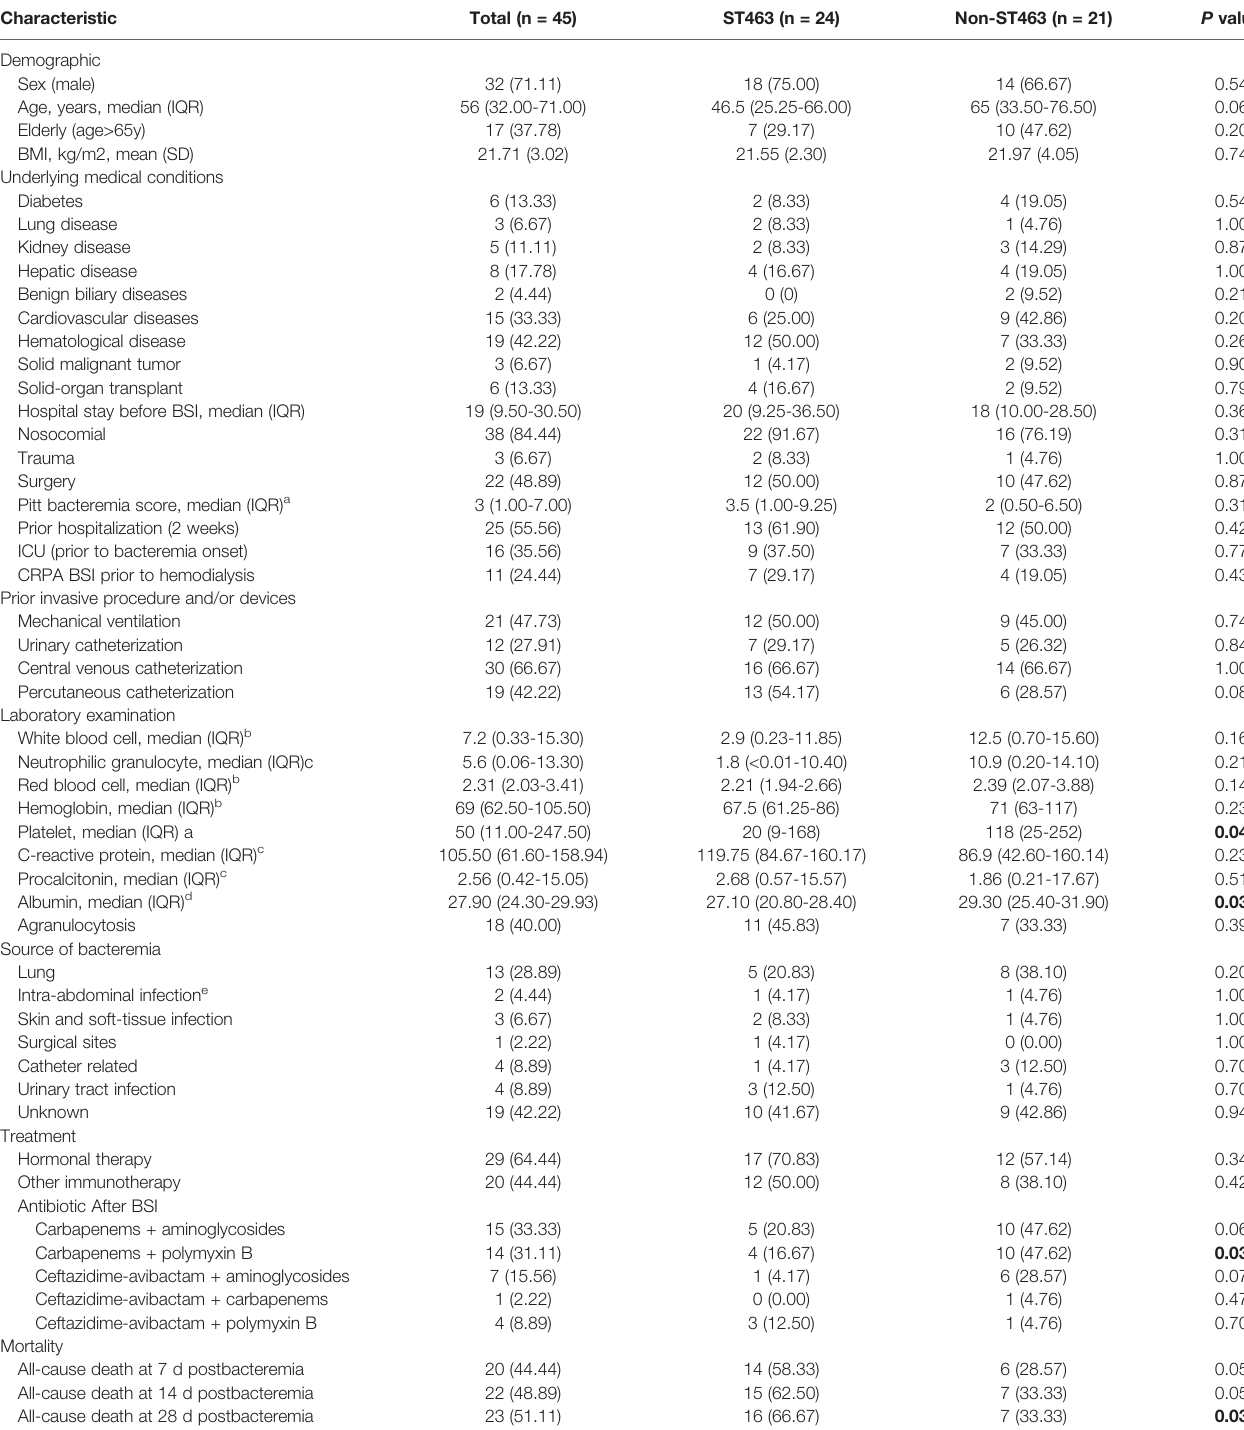
TABLE 1 | Characteristics of patients with bloodstream infections caused by Carbapenem-Resistant P. aeruginosa according to sequence typing.